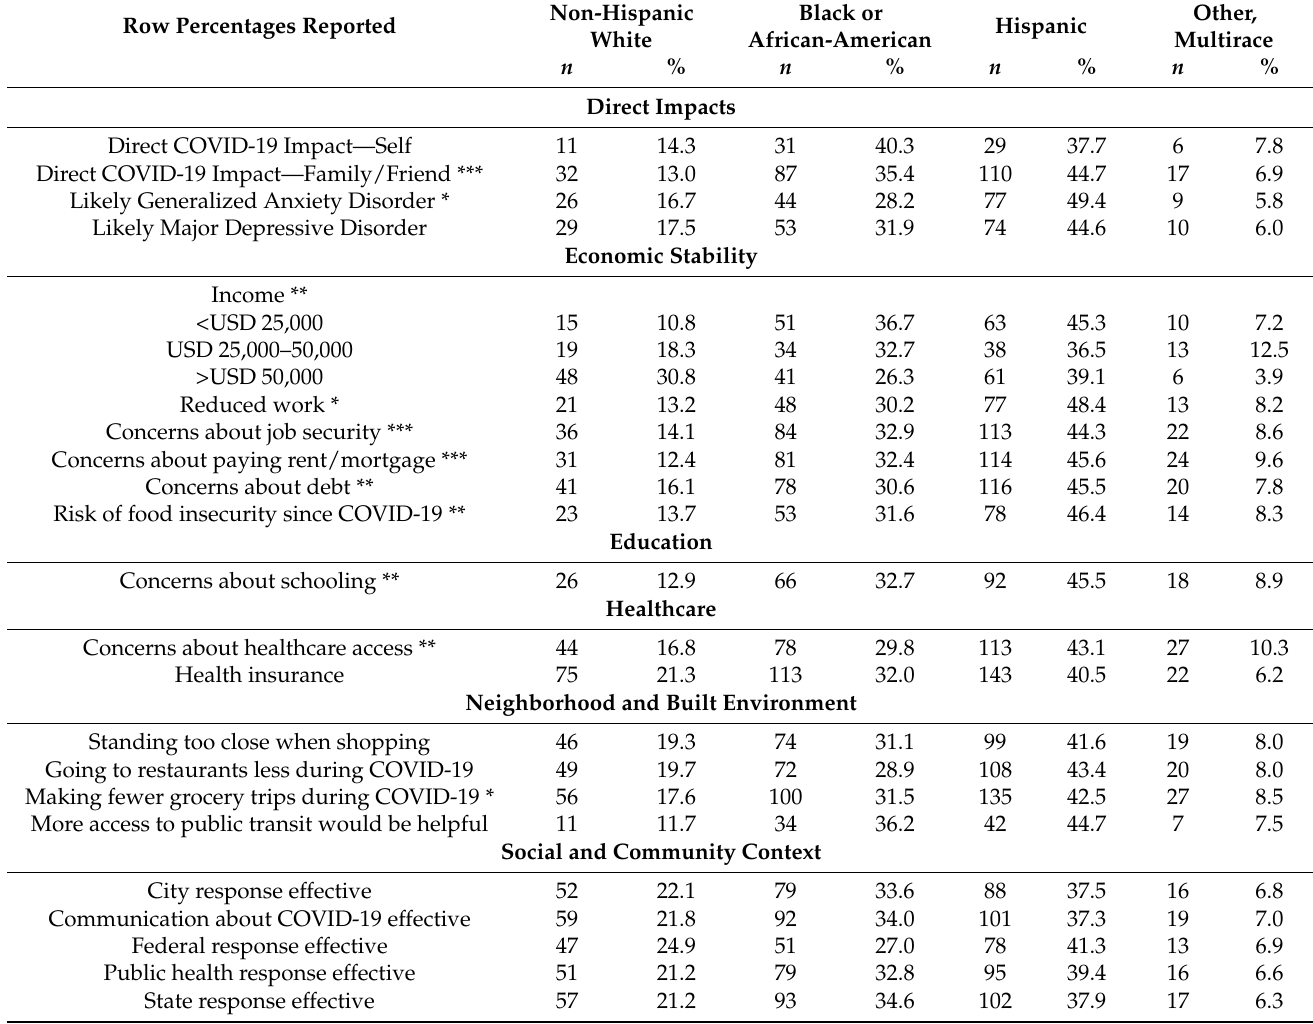
Table 3. Race and ethnic group differences for primary and secondary COVID-19 social and health impacts (chi2). Row Percentages Reported